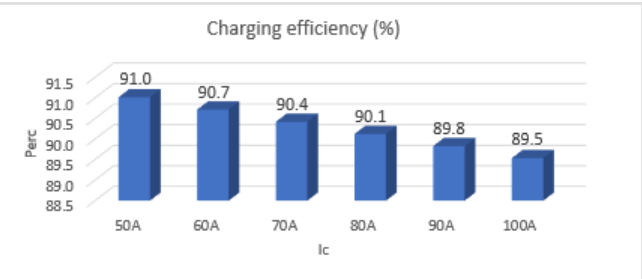
Figure 32. Diagrams of SC circuit charging efficiencies in the case of a six-phase converter with ∆ V x = 0.6 V, ∆ D 0 = 25% at different constant currents.